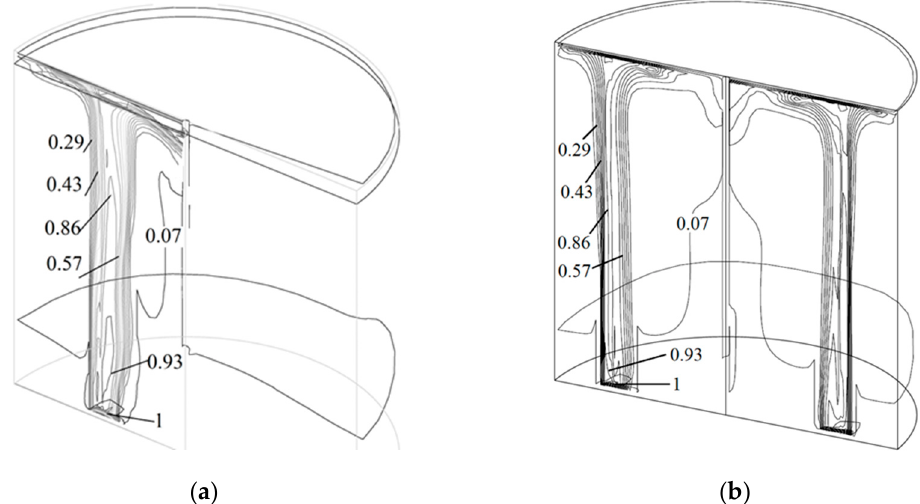
Figure 7. Gas plume that forms in the mathematical simulation of the ladle furnace adopted a cylindrical shape and shows a greater fraction of gas in the central axis of the plume and has a single plume for ( a ) single plug gas injection and two plumes for ( b ) dual plug gas injection.